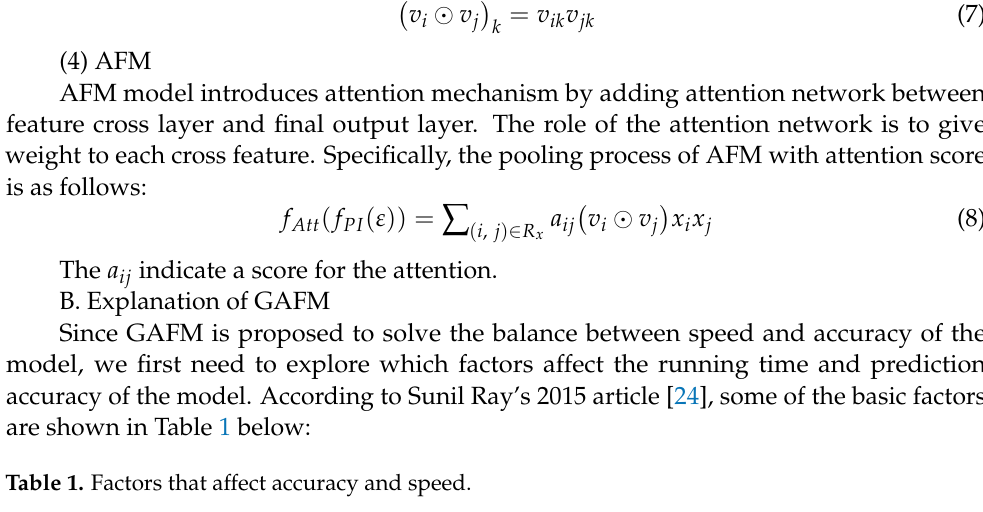
Table 1. Factors that affect accuracy and speed. Complexity Complexity Embedding Regularization of Model of Data accuracy ↑ ↑ ∼ ∼ ↑ speed ↓ ↓ ↓ ↓